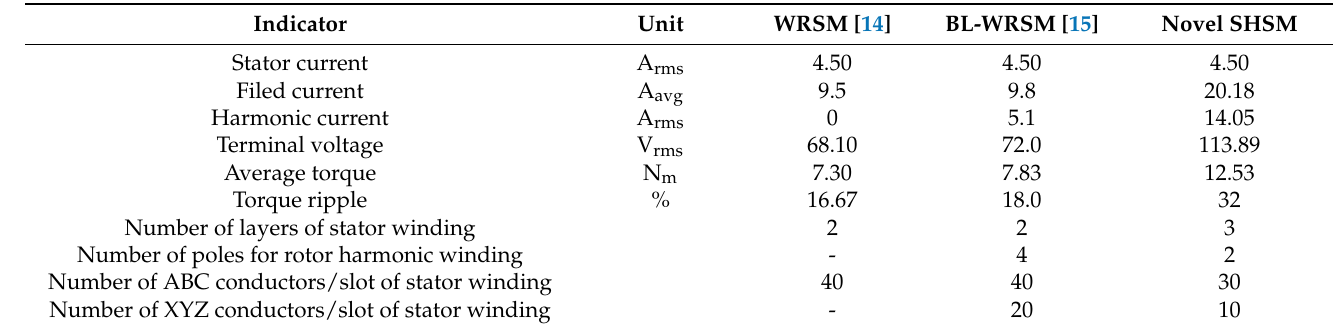
Table 2. Performance comparison between the conventional WRSM [14], BL-WRSM [15], and the proposed SHSM.